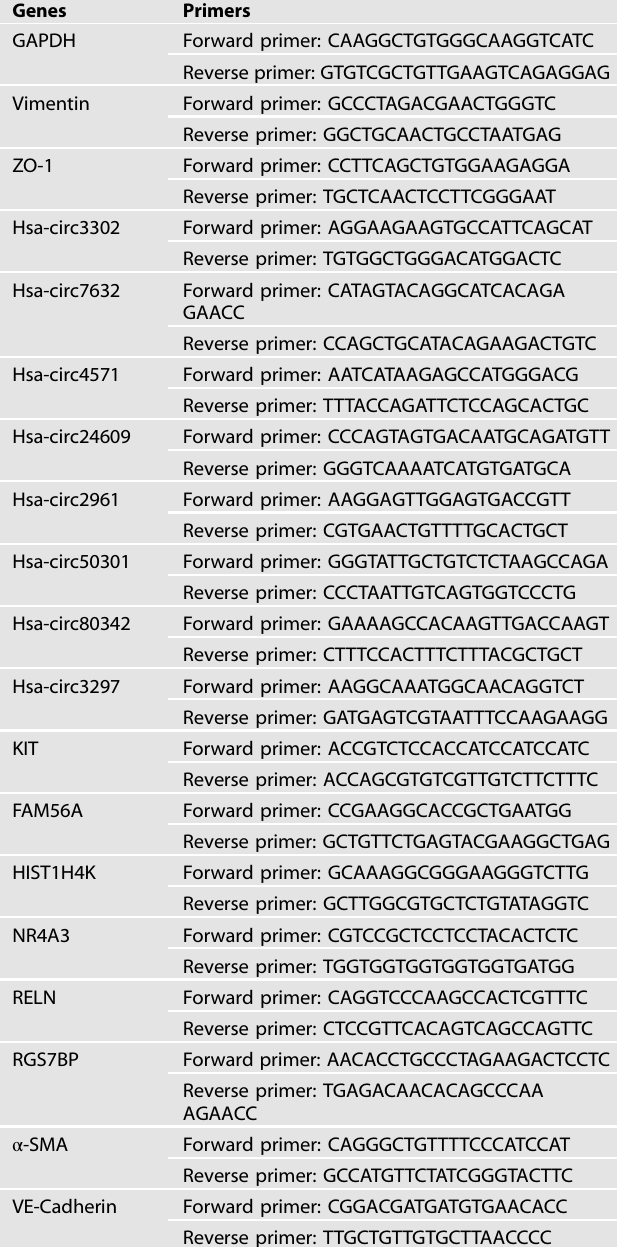
Table 1. List of primers used in this